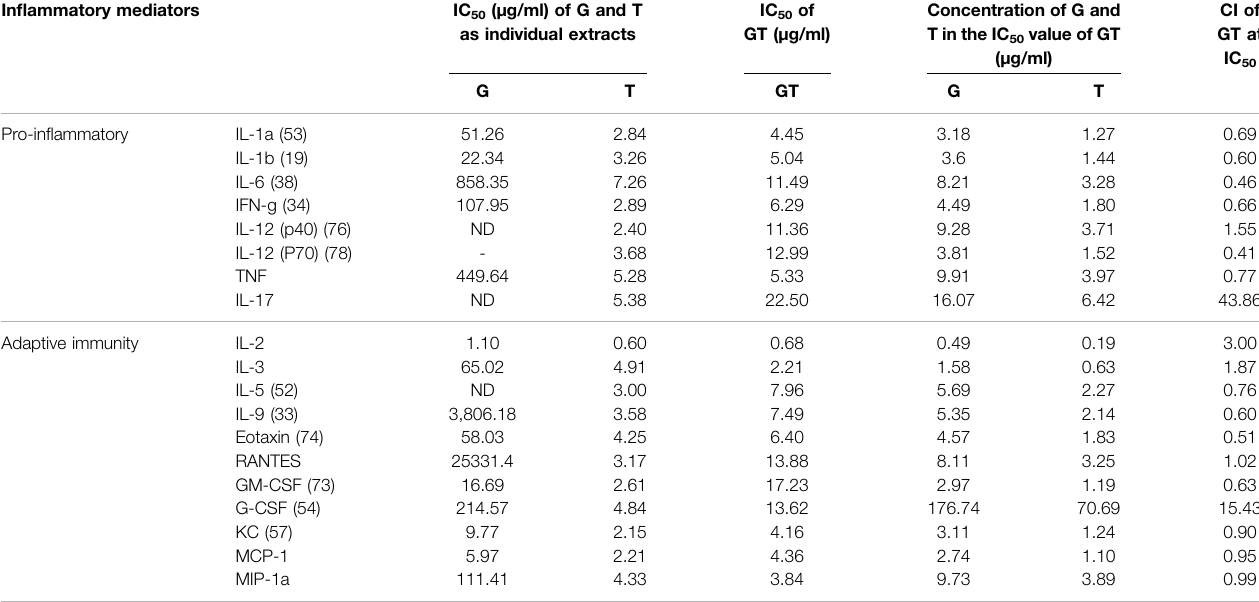
TABLE 2 | Synergistic effects of G-T 5:2 in inhibiting LPS and IFN- γ -induced cytokines in RAW 264.7 cells. Data are shown as mean IC 50 and CI values at IC 50 from duplicates. In fl ammatory mediators IC 50 (µg/ml) of G and T